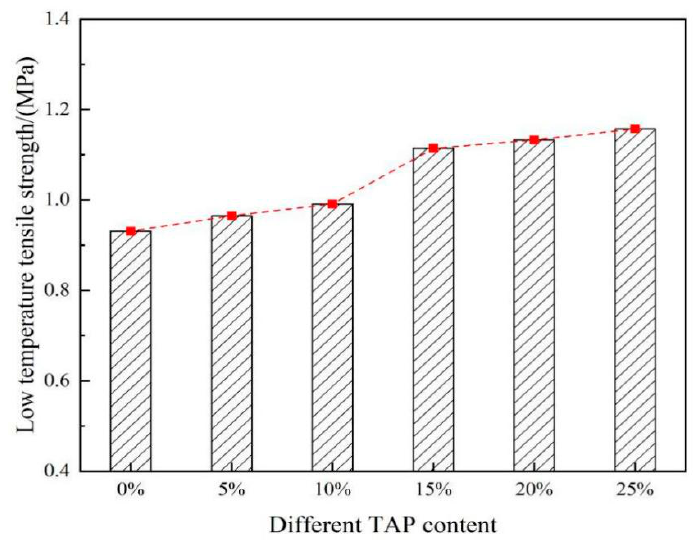
Figure 6. The SCB tensile strength results.